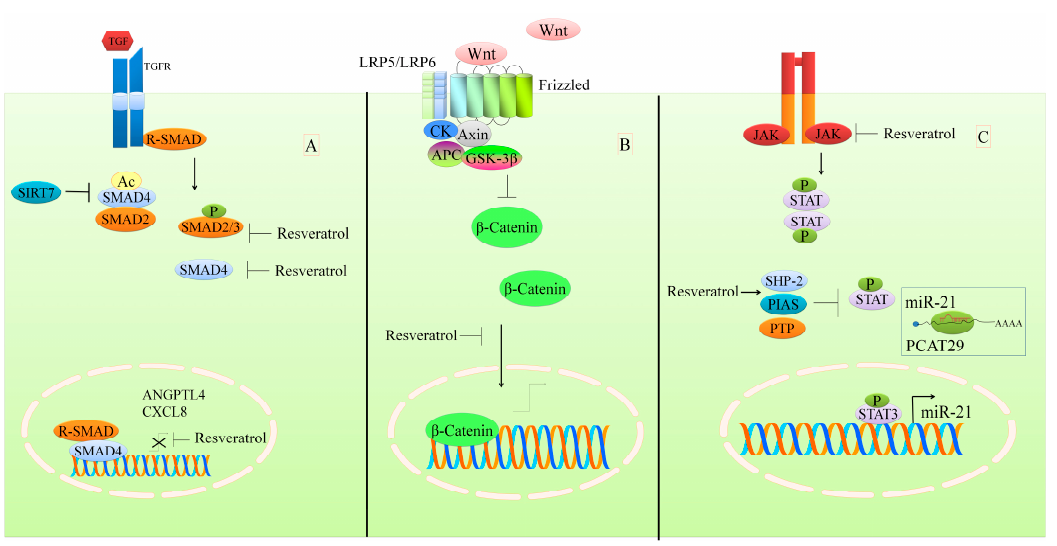
Figure 3. An overview of resveratrol-mediated targeting of multiple signaling pathways. ( A ) TGF/SMAD signaling pathway regulation by resveratrol; ( B ) WNT/Catenin pathway regulation by resveratrol; ( C ) Resveratrol increases negative regulators of STAT signaling (SHP-2, PIAS, and PTP) and inhibits JAK-mediated STAT phosphorylation. STAT3 transcriptionally upregulates miR-21, and targets the tumor suppressor gene PCAT29.